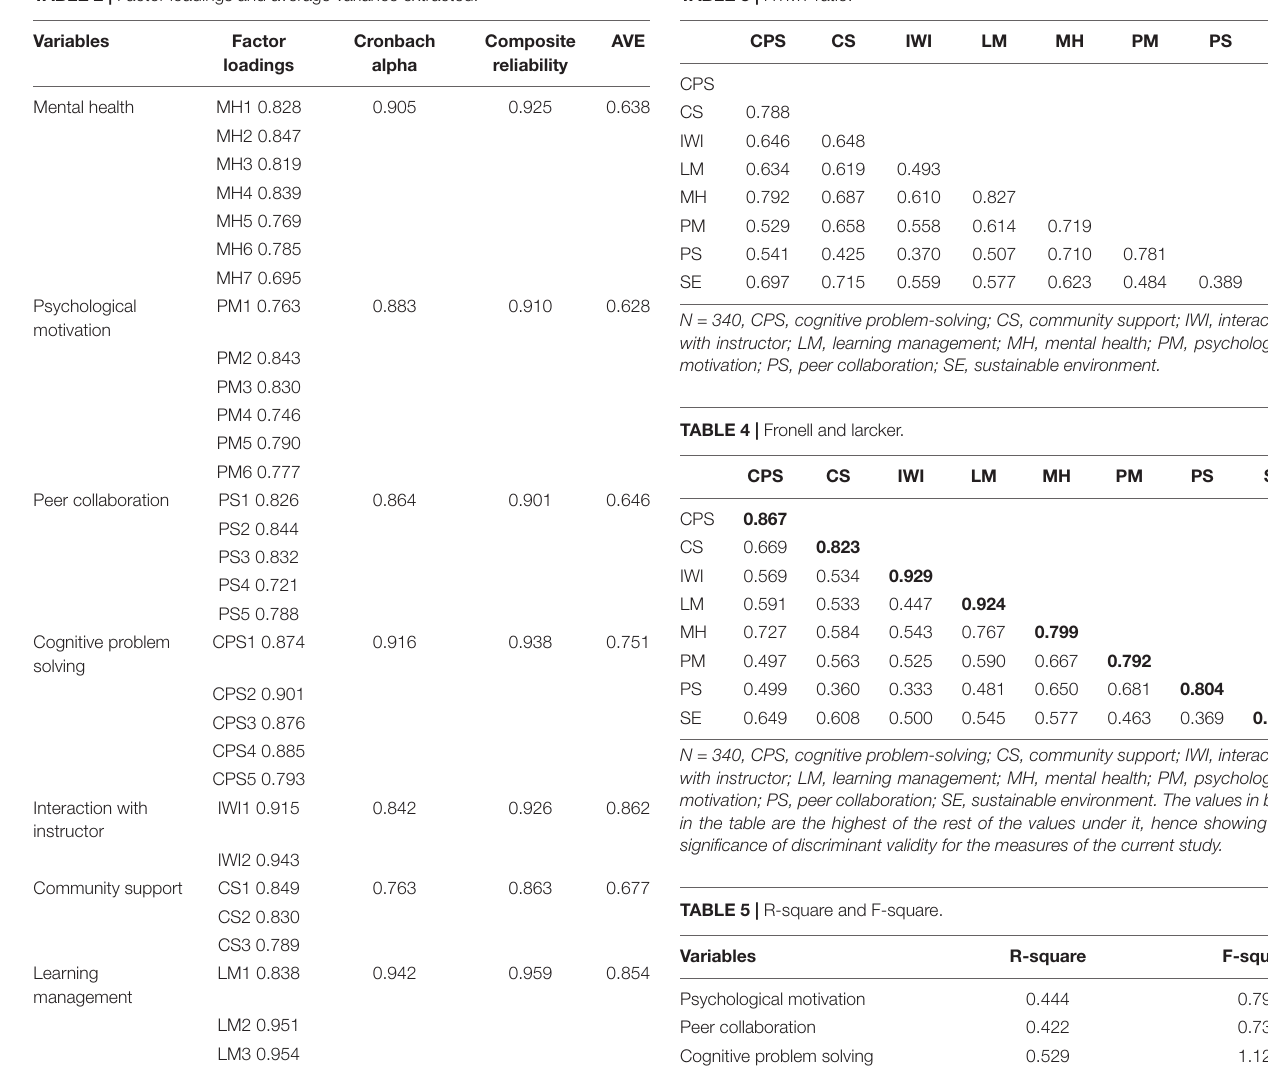
TABLE 3 | HTMT ratio.